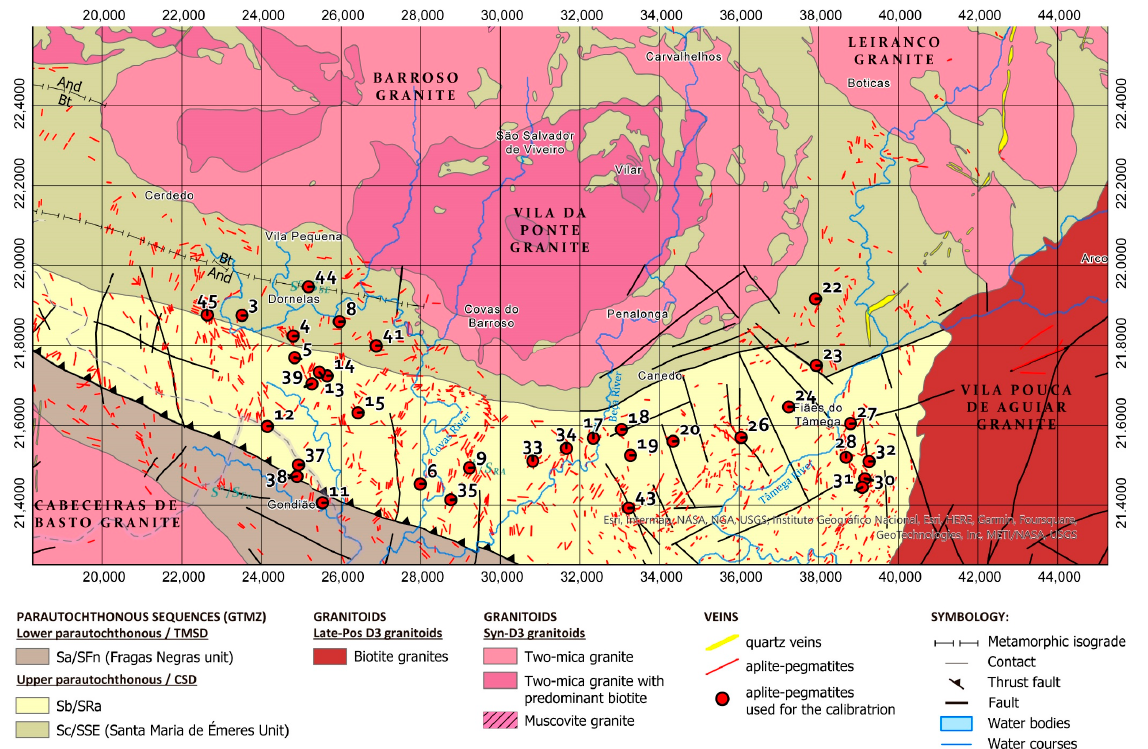
Figure 1. Geologic map of the Barroso–Alv ã o aplite-pegmatite field with the location of the pegmatites used for the LIBS calibrations (red dots). Coordinates system: ETRS 1989 Portugal TM06. Adapted from Rodr í guez Fern á ndez, et al. [4], Ag ê ncia Portuguesa do Ambiente [5,6], Sant’Ovaia, et al. [7] and Ribeiro, et al. [8]. © Agência Portuguesa do Ambiente (APA). Available online: https://sniamb. apambiente.pt/content/geo-visualizador (accessed on 19 July